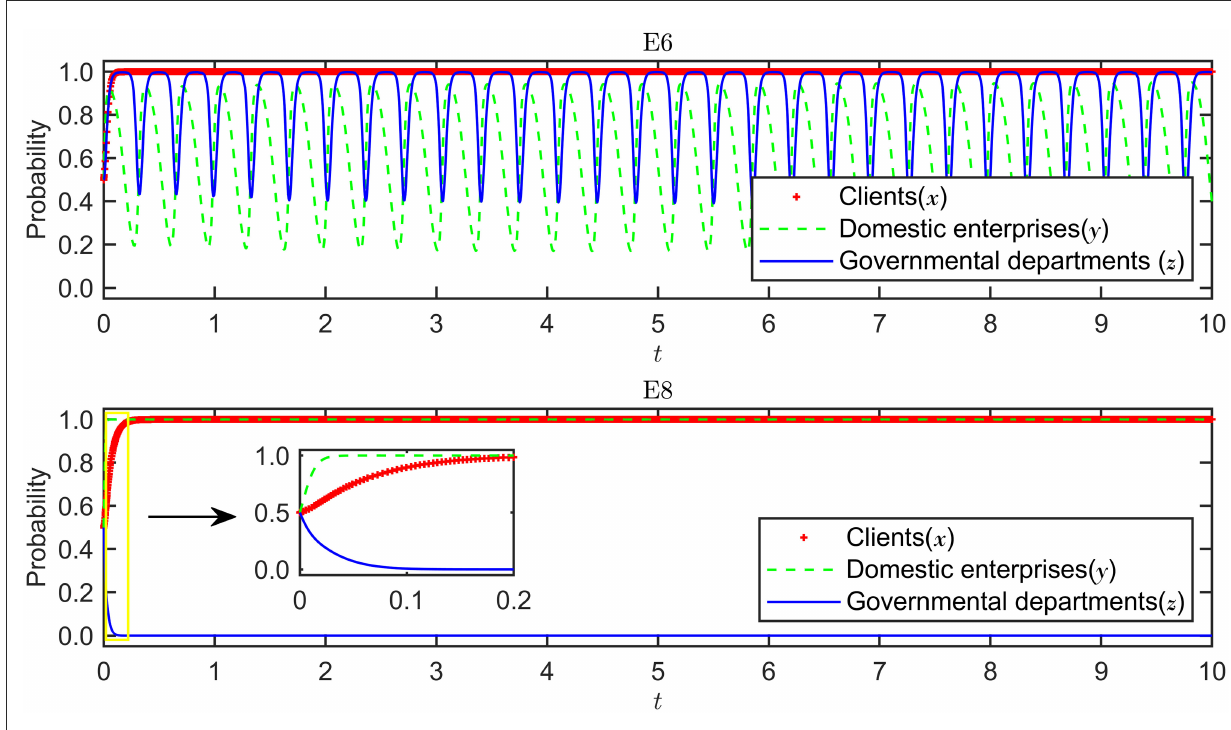
FIGURE5 Evolutionary stability of E 6 and E 8 .